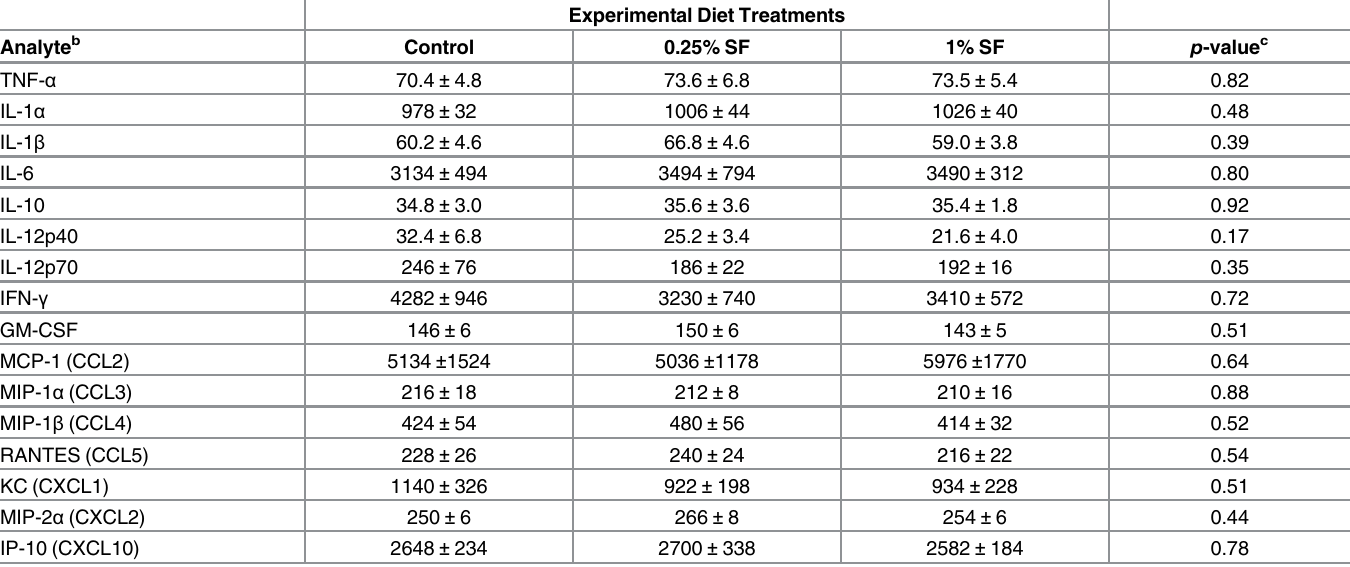
Table 2. S . frutescens (SF) Consumption Failed to Impact Circulating Cytokines and Chemokines in BALB/c Mice 24 hr Following an in vivo Chal- lenge with L . monocytogenes . a Experimental Diet